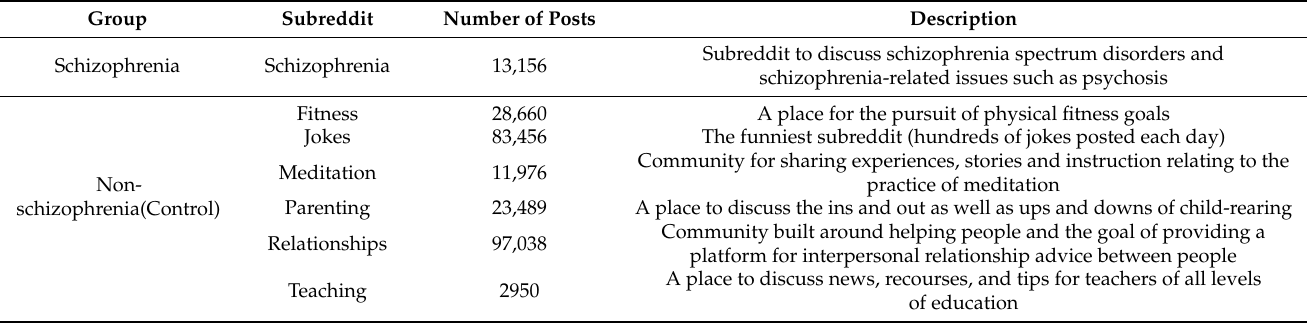
Table 1. Summary and description of the collected data from